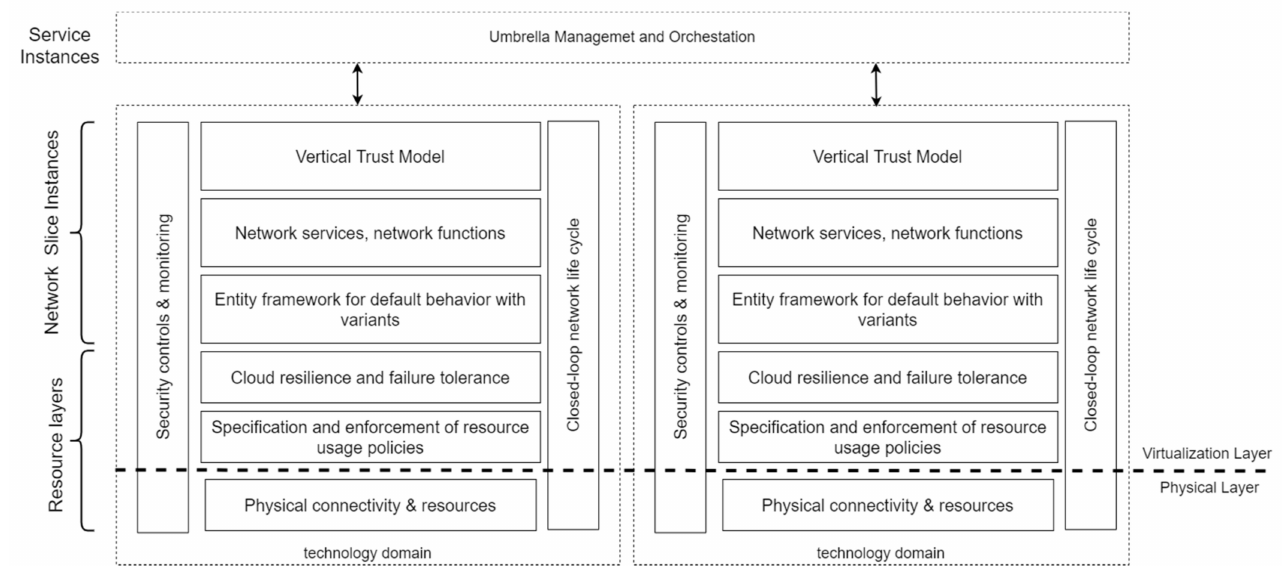
Figure 5. Network slice isolation